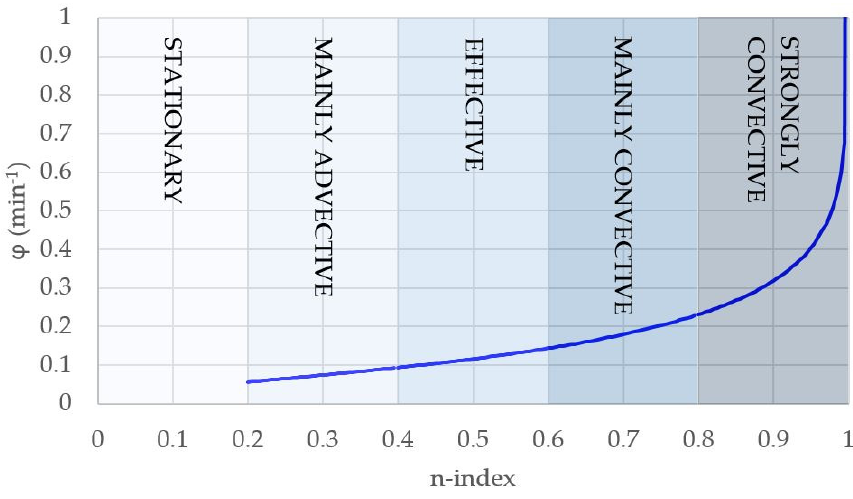
Figure 6. Relationship between the n-index and ϕ.